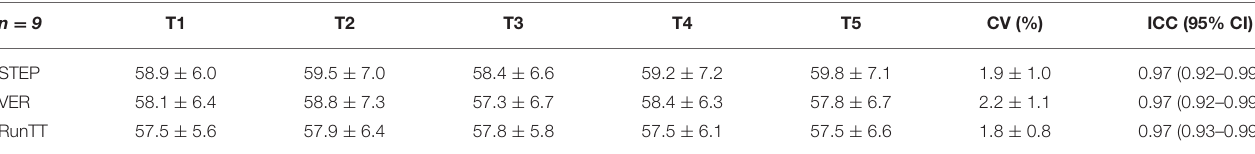
TABLE 2 | Mean ± SD of ˙ VO 2 max (mL · kg − 1 · min − 1 ) for each trial for the incremental test to volitional exhaustion (STEP), the verification phase (VER), and the four-minute running time-trial (RunTT) with associated coefficient of variation (CV) and intraclass correlation coefficient (ICC) data.